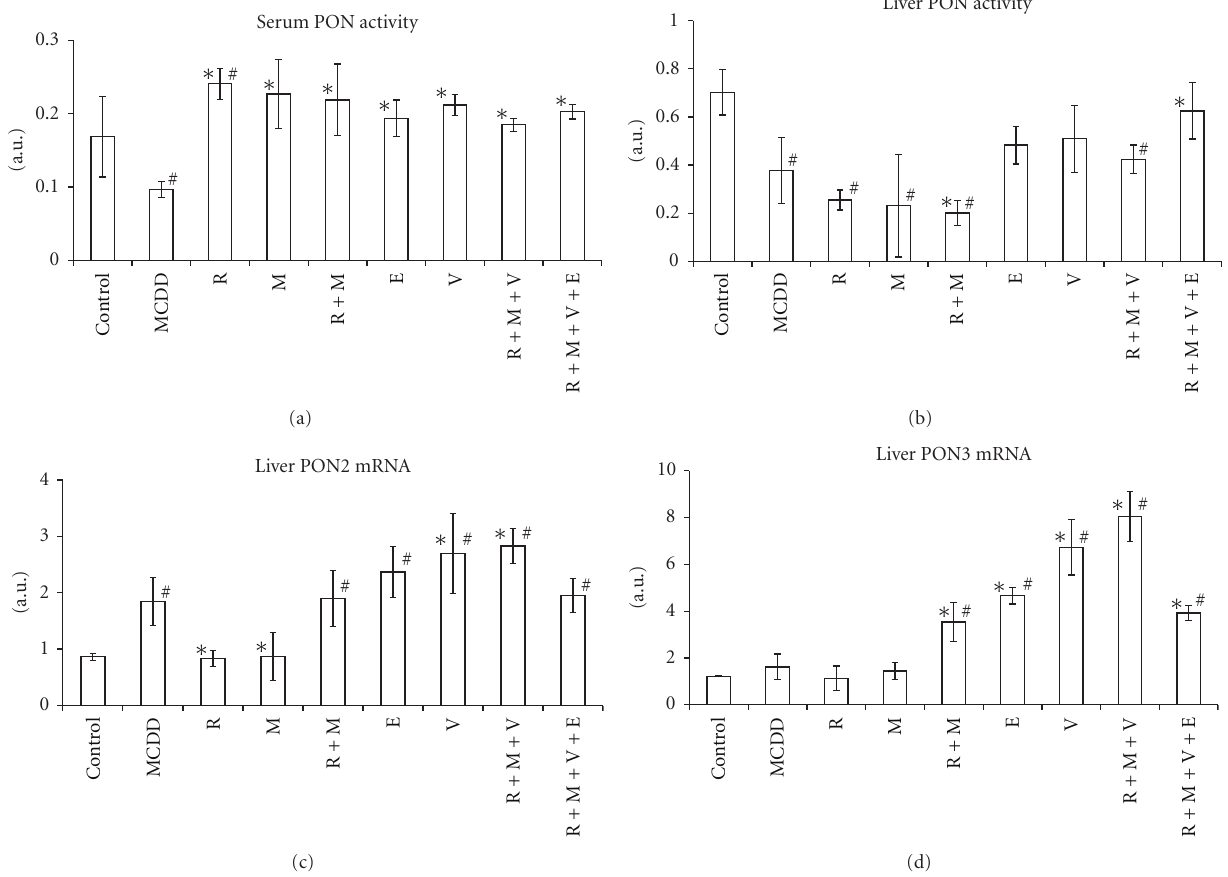
Figure 2: Paraoxonase (PON) activity in sera (a) and livers (b); PON2 (c) and PON3 (d) mRNA expression in rat experimental fatty liver model. Fatty liver in Sprague-Dawley rats was induced by methionine-choline deficient diet (MCDD) for 9 weeks. Rats were treated for other 6 weeks with rosiglitazone (R); metformin (M); rosiglitazone + metformin combination (R+M); ezetimibe (E); valsartan (V); rosiglitazone + metformin + valsartan in combination (R+M+V) or rosiglitazone + metformin + valsartan + ezetimibe (R+M+V+E). “ # ” indicates P < 0 . 05 versus control group (fed by standard rat chow). “ ∗ ” indicates P < 0 . 05 versus MCDD group.